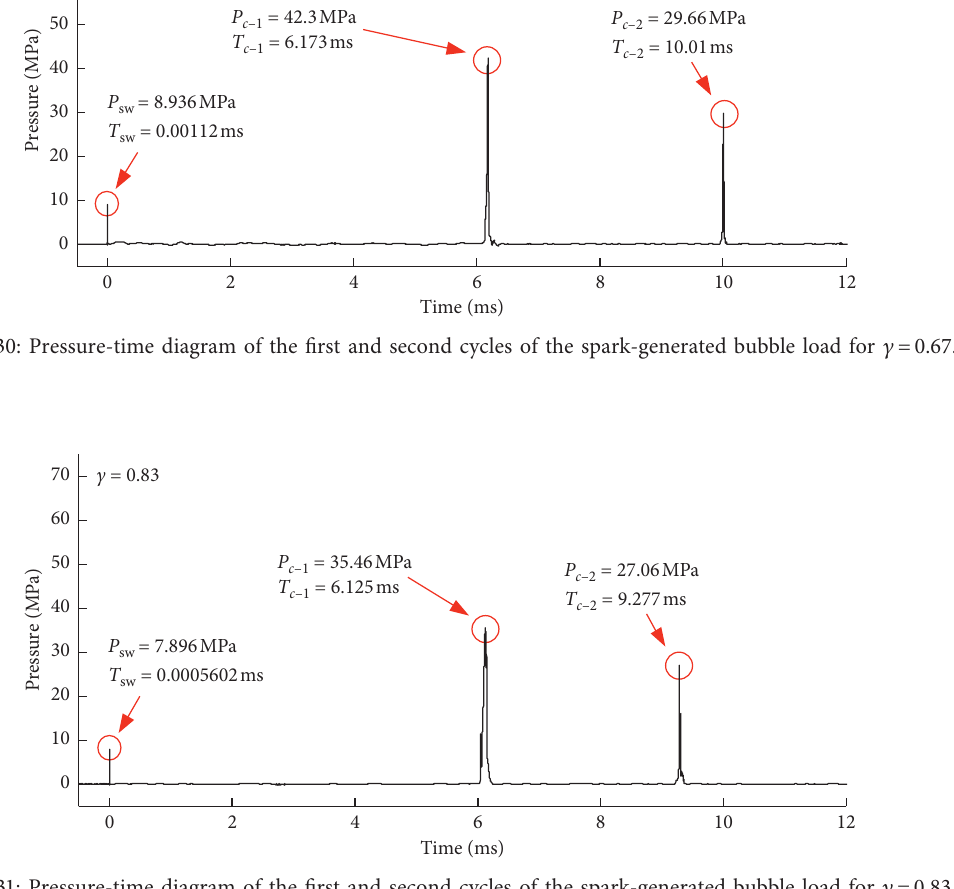
Figure 31: Pressure-time diagram of the first and second cycles of the spark-generated bubble load for c � 0.83.